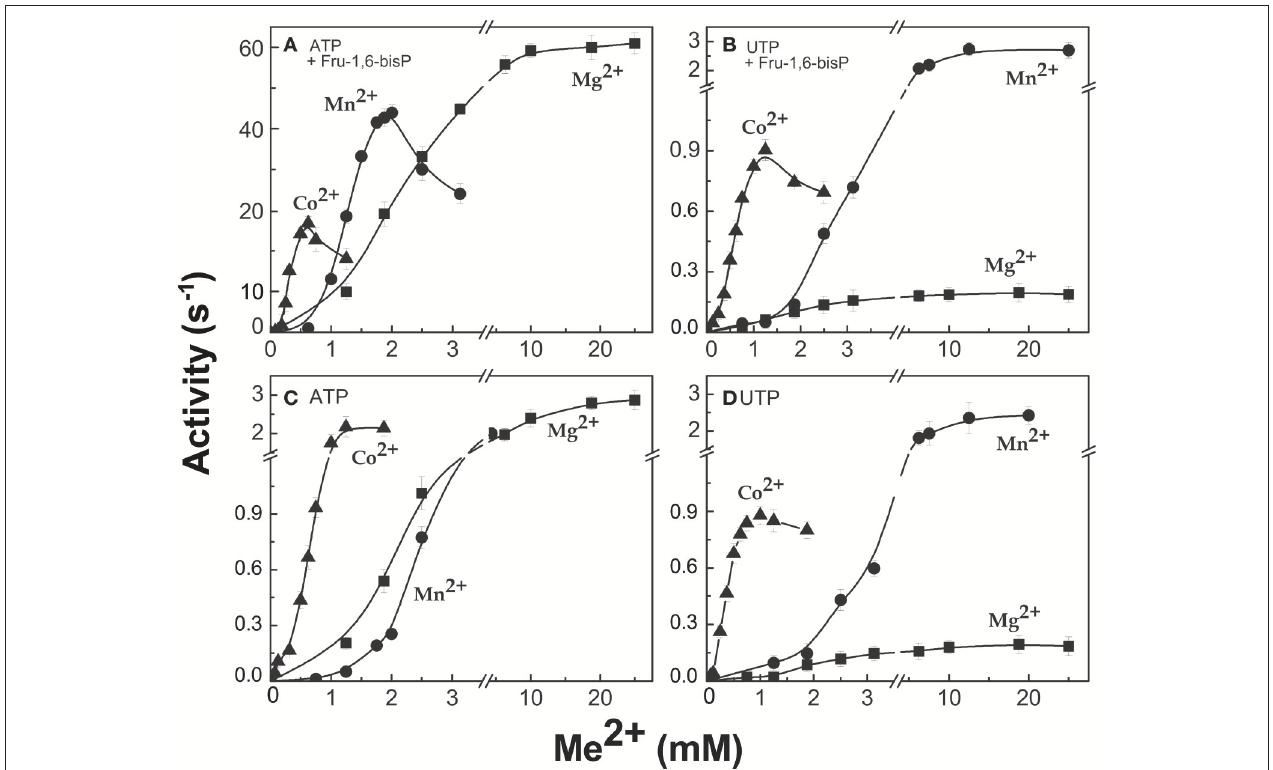
FIGURE 2 | ADP-Glc PPase activity with different divalent cations as cofactor of the reaction. Activity was measured in presence (A,B) and absence (C,D) of Fru-1,6-bisP. Error bars are SD of three independent sets of data.